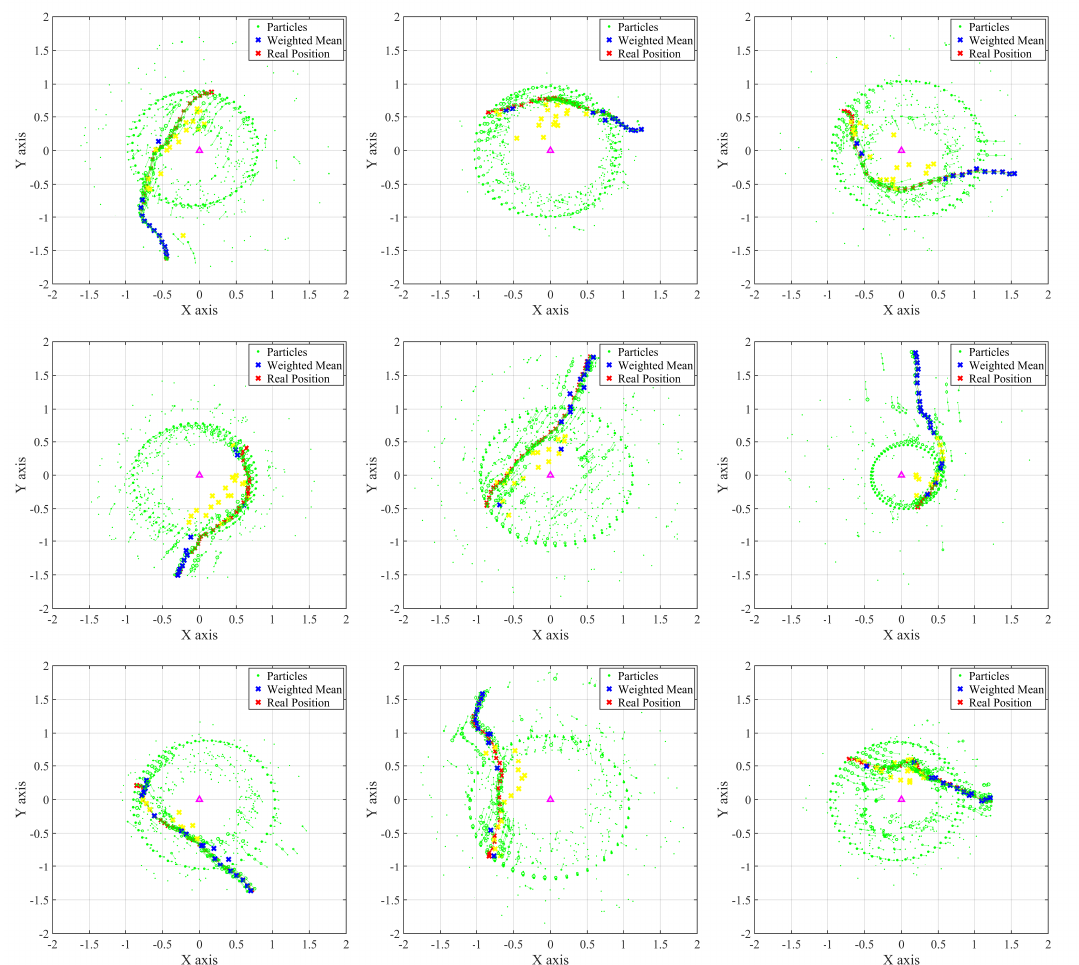
Figure 8. Cumulative representation of particle updates in random